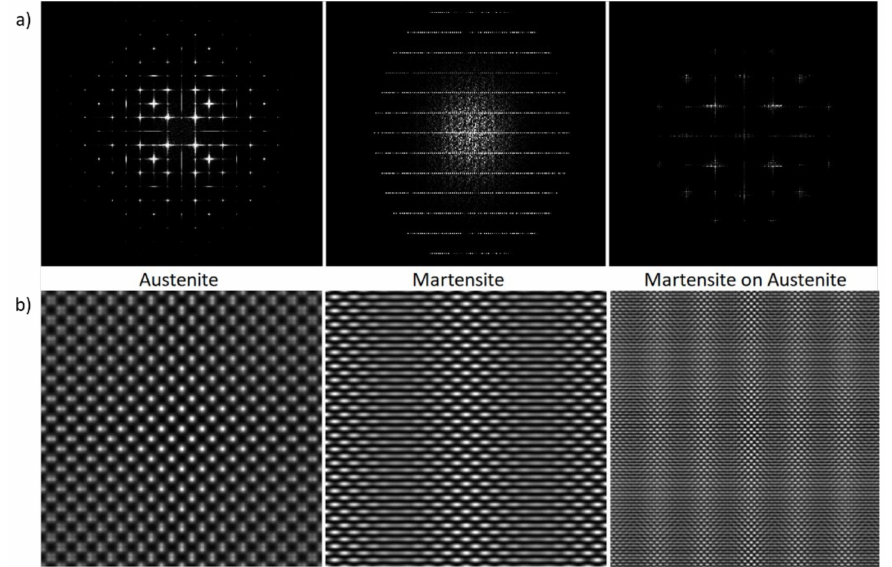
Figure 4. ( a ) Multislice simulation of diffraction images for the pure austenitic (left) and martensitic (centre) phase of NiCoMnAl and 3 nm martensite on top of 3 nm austenite (right). ( b ) Corresponding TEM images created via FFT of the diffraction pattern. The images are still depending on parameters such as defocus and camera